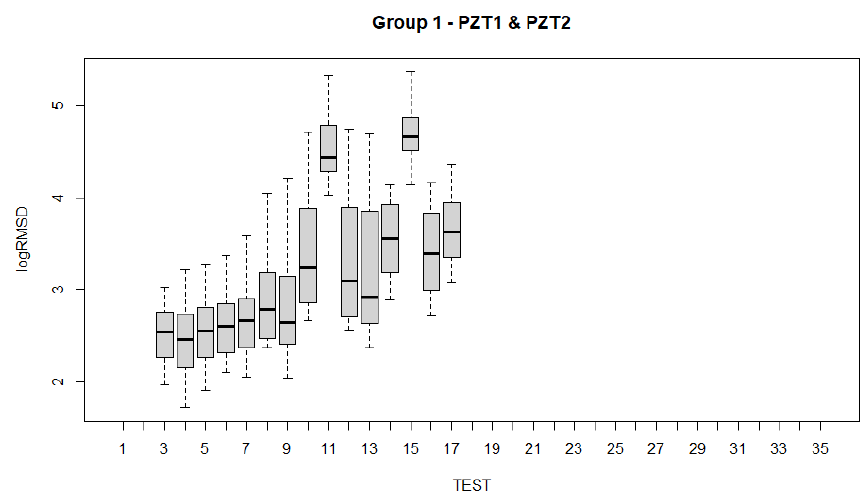
Figure 18. Boxplot for sensors of group 1.